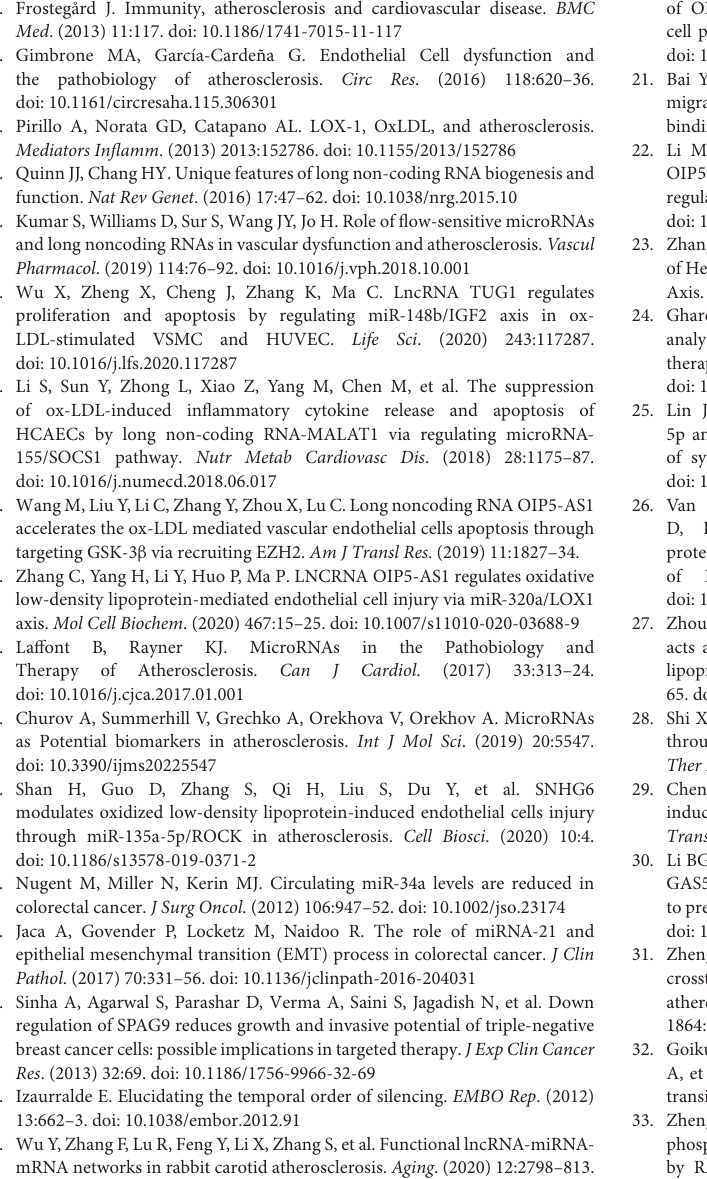
Supplementary Figure 4 | The impact of miR-135a-5p level on OIP5-AS1 expression. HUVECs were transfected with miR-NC mimic, miR-135a-5p mimic, anti-miR-NC, or anti-miR-135a-5p, followed by the detection of OIP5-AS1 expression by qRT-PCR. n = 3 independent biological replicates; error bars represented SD; P > 0.05 by one-way ANOVA with Tukey’s post hoc test. Supplementary Figure 5 | The expression of CLIC4, TXNIP, PAPPA, and KLF5 by qRT-PCR in HUVECs transfected with miR-NC mimic or miR-135a-5p mimic. n = 3 independent biological replicates; error bars represented SD; ∗∗ P < 0.01 or ∗∗∗∗ P < 0.0001 by Student’s t